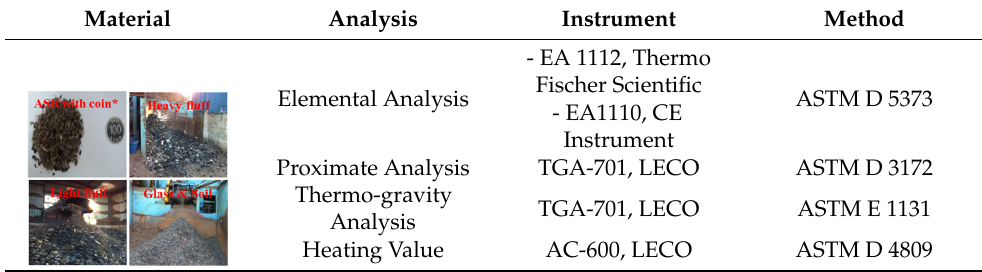
Table 2. Analysis Instruments &